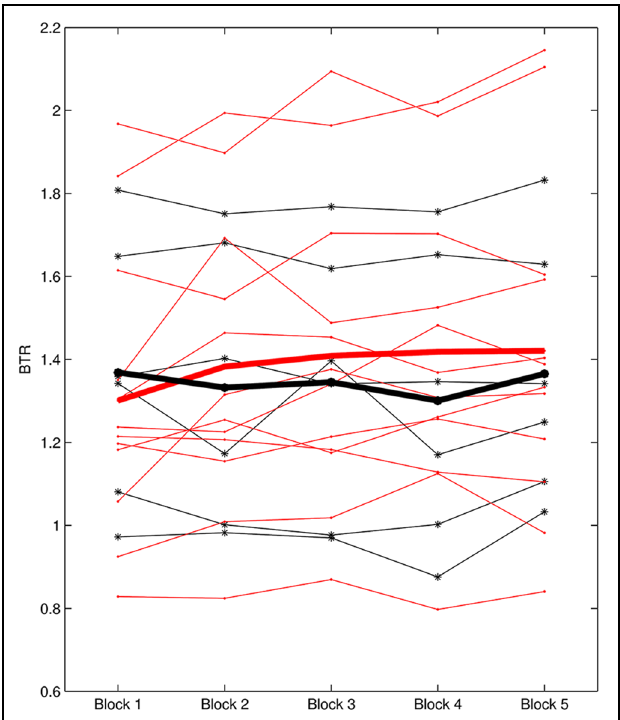
FIGURE 3 | BTR within sessions of learner_L1 and non-learner_L1. Thin red lines with dot represent BTR of each learner; thick red line represents the mean BTR across all learners; thin black lines with star show each non-learner; thick black line represents the mean across non-learners.